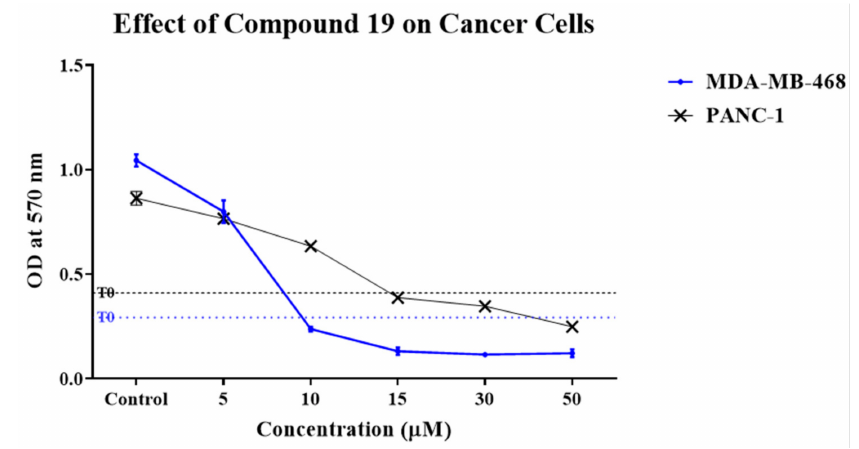
Figure 2. Representative dose–response profiles demonstrating growth-inhibitory effects of 19 against MDA-MB-468 and PANC-1 cells. The assay was repeated at least three times. Points and error bars refer to the mean ±